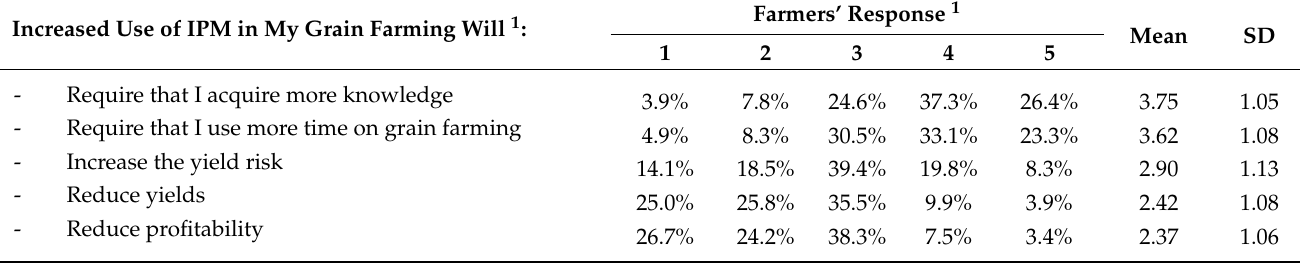
Table 1. Respondent perceptions about what increased use of IPM would imply for their farming (N = 617, Post-survey).